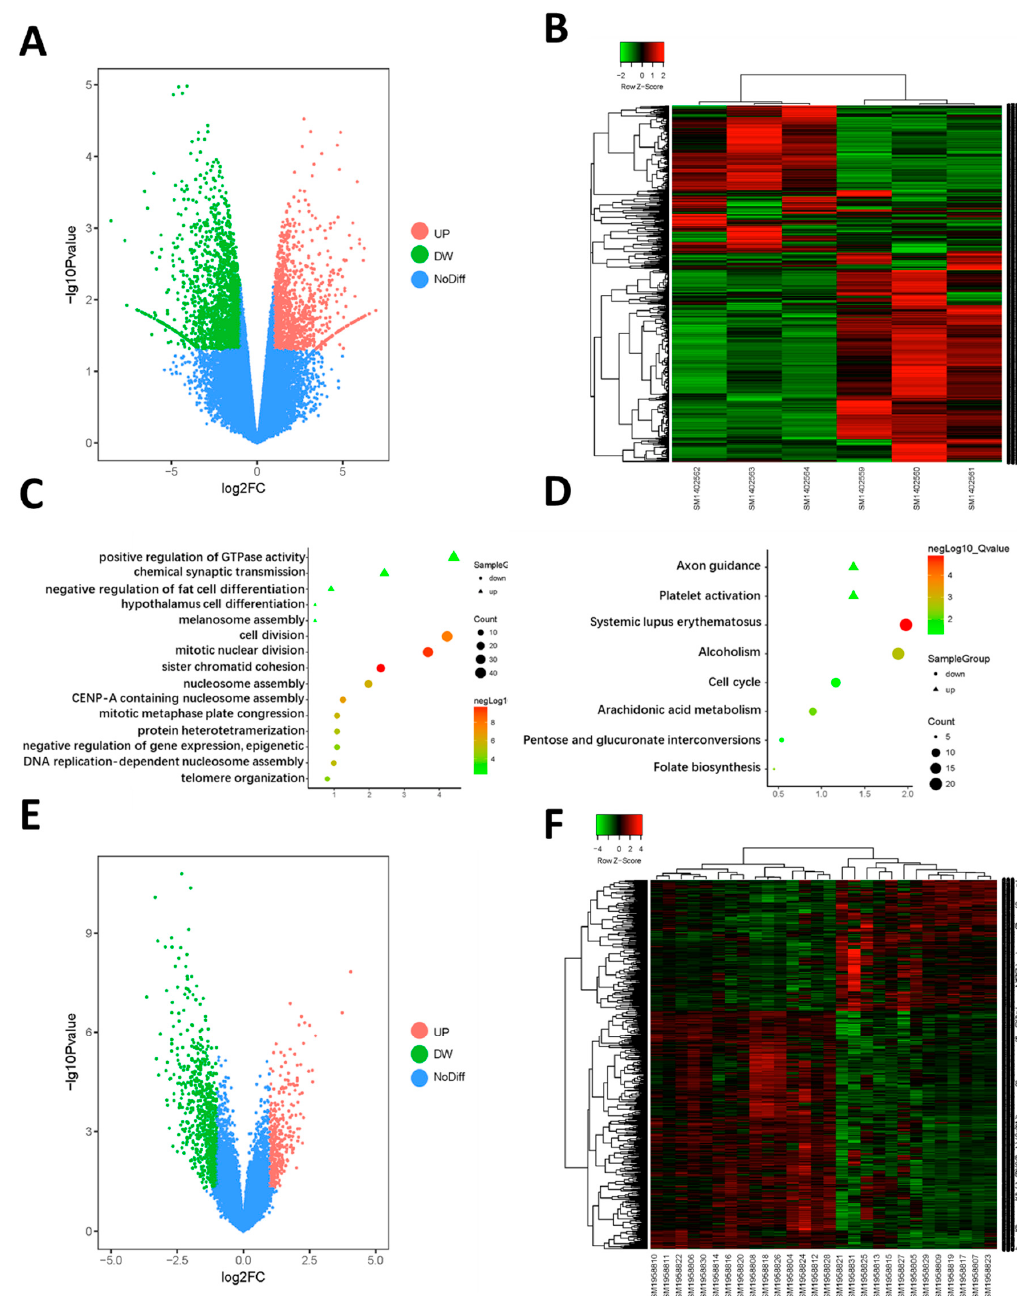
Figure 1. ( A ) Volcano plot visualizing differentially expressed genes (DEGs) in GSE58162 (three groups of control samples and three groups of aspirin treated samples). The vertical lines demark the fold change values. The right vertical line corresponds to ≥ 2-fold up and the left vertical line ≥ 2-fold down changes, while the horizontal line marks a − log10p-value of 0.05. ( B ) Heat map hierarchical clustering reveals DEGs in aspirin treated groups compared with control groups. ( C ) Functional enrichment analysis of DEGs in GSE58162. Significantly enriched biological processes were ranked by p -value by using the Database for Annotation, Visualization, and Integrated Discovery (DAVID). A p -value <0.05 was regarded significant. ( D ) KEGG pathway enrichment analysis of DEGs in GSE58162. Significantly enriched pathways were ranked by p -value, using DAVID. A p -value <0.05 was regarded significant. ( E ) Volcano plot visualizing DEGs in GSE75538 (14 oral squamous cell carcinoma (OSCC) samples and 14 matched normal samples). ( F ) Heat map hierarchical clustering reveals DEGs in OSCC groups compared with normal